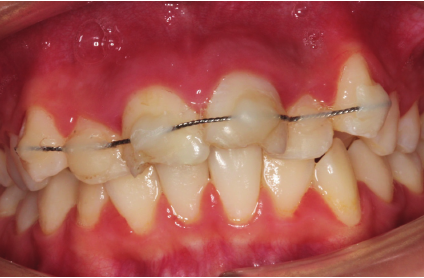
Figure 7: Splinting of the avulsed tooth with orthodontic wire and composite resin.